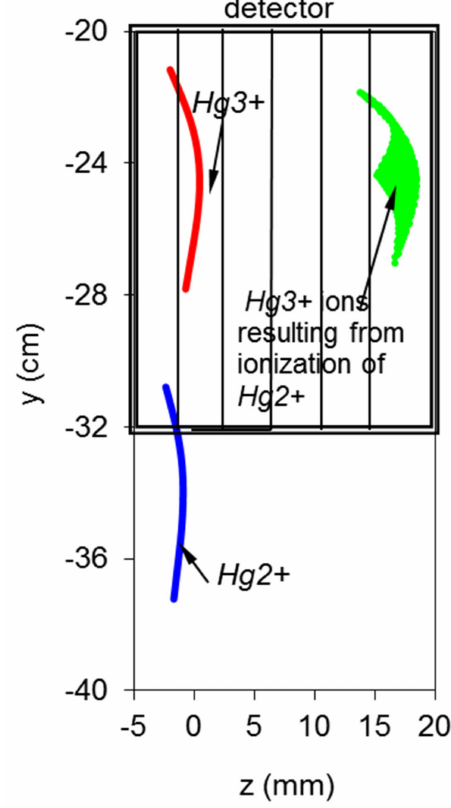
Figure 14. Footprint of Hg ions in the detector area. The boxed area corresponds to the MCAD real size.